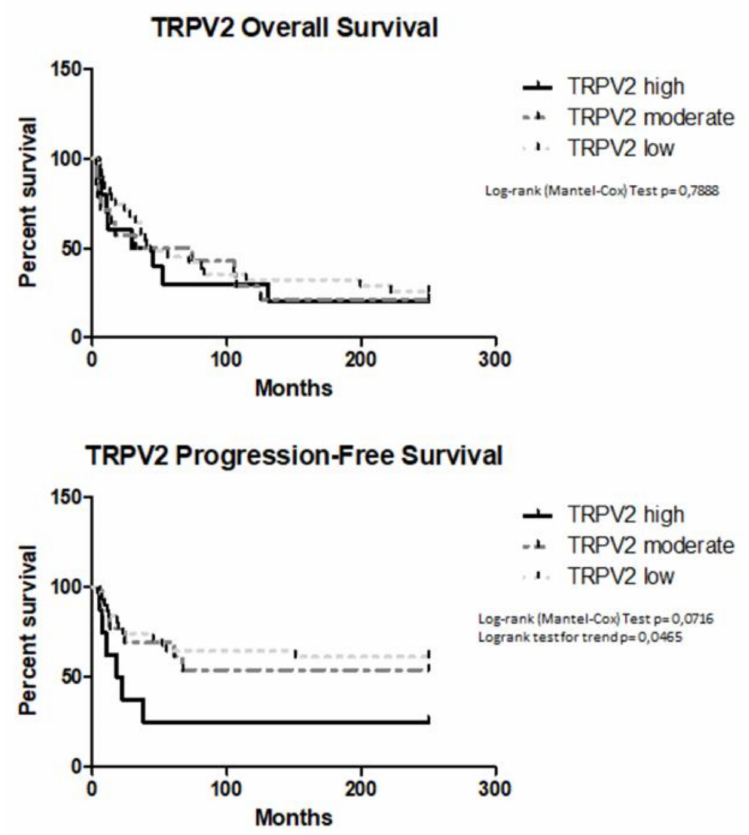
Figure 3. Survival of EC patients according to TRPV2 expression. Kaplan–Meier survival curves showing OS (overall survival) and PFS (progression-free survival) of EC patients. The log-rank test with corresponding P values applies to the TRPV2—high, TRPV2—moderate and TRPV2—low